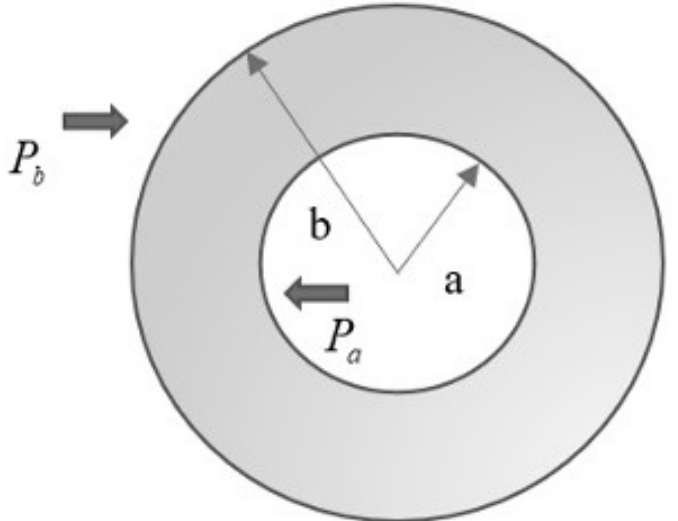
Figure 1. Axisymmetric functionally graded cylinder with inner radius a , outer radius b and under internal and external pressure, P a and P b ,